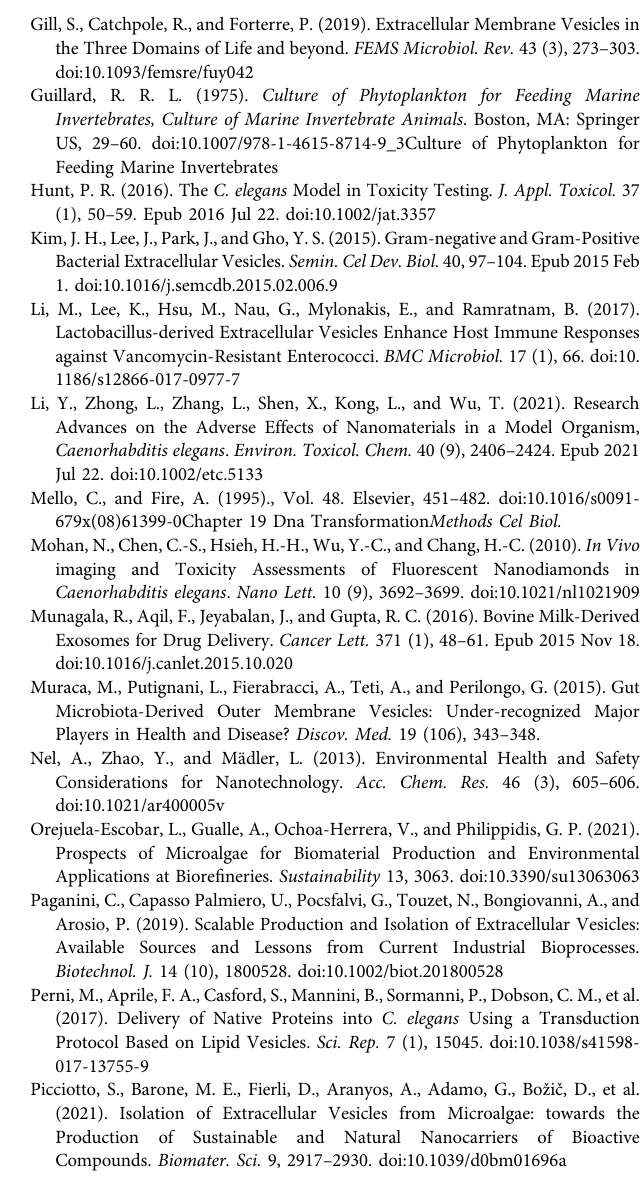
Supplementary Figure S2 | Additional pictures of animals treated with Di-8- Anepps-nanoalgosomes by soaking, in solido or injection. Intestinal cells have uptaken the labelled EVs (arrows), and some are still visible in the lumen after soaking (asterisk). Bright fi eld (left) and epi fl uorescence with FITC fi lter images are shown (right). Upper panel shows a young adult animal; in the middle panel an L4 stage larva is depicted; the lower panel shows an old adult with several eggs in the uterus. Scale bar 75 µm. Anterior is left, ventral is